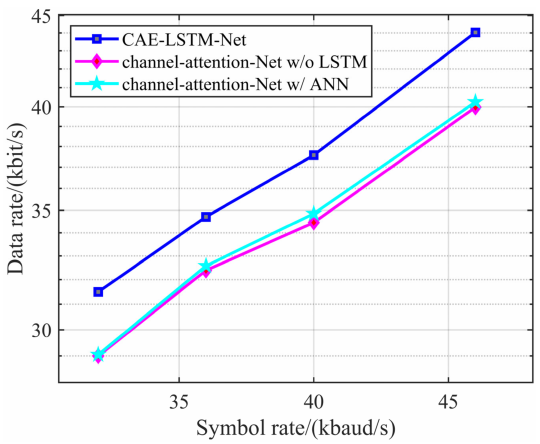
Figure 14. Data rate comparison by using different equalizers.